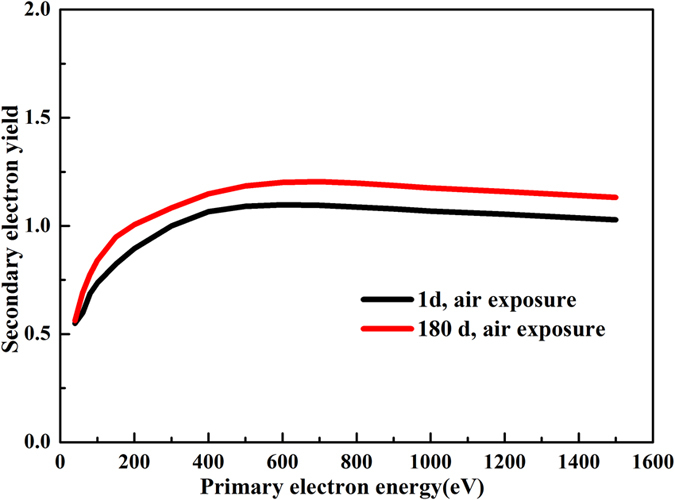
SEY of porous Ag/TiO2/Au coatings for 1 d and 180 d air exposure.